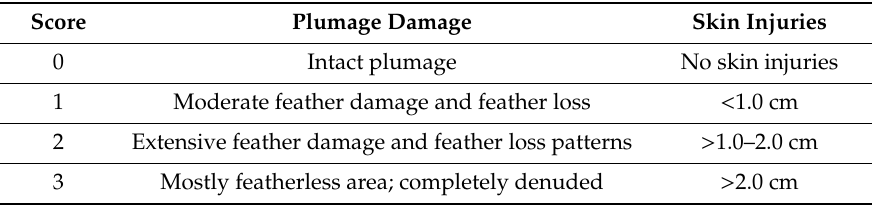
Table 1. Scoring system of plumage and skin condition of the hens in accordance with the Animal Protection Guideline for Laying Hens and Pullets with Intact Beak of Lower Saxony